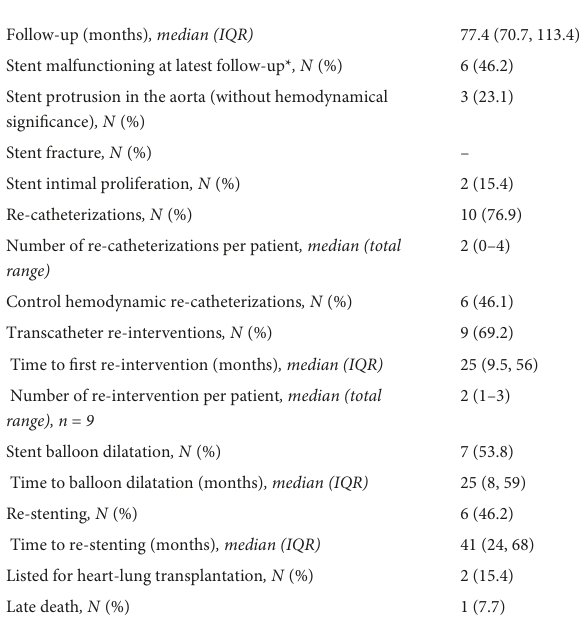
TABLE 3 Final procedural outcomes.